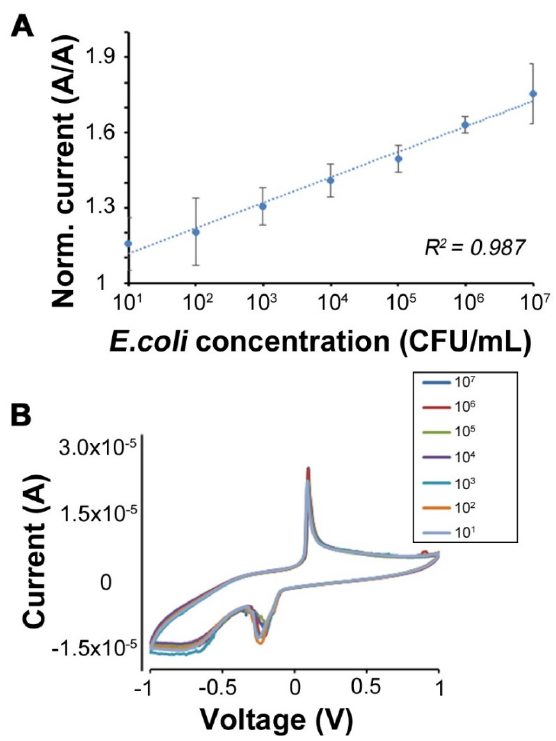
Figure 5. Analysis of Chi-AgNPs modified electrodes for E. coli detection over 10–10 7 CFU/mL ( A ) Calibration curve showing the linear response over seven orders of magnitude in concentration. Here, the currents have been normalized to their value at 0 (blank). n = 3 different samples tested; error bars represent standard deviation for three independent experiments; ( B ) example CV showing the response to increasing E. coli